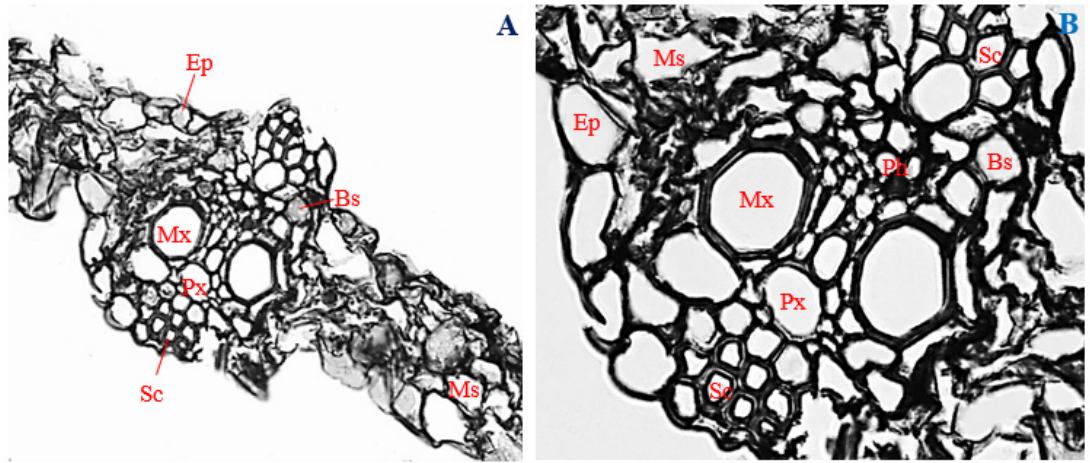
Figure 11. Transverse section of corn leaf infected with endophytic Penicillium citrinum . ( A ) Magni- fication 200×; ( B ) magnification 400×. Ep, epidermis; Sc, sclerenchyma; Ph, phloem; Mx, metaxylem; Px, protoxylem; Bs, bundle sheath; and Ms, mesophyll.